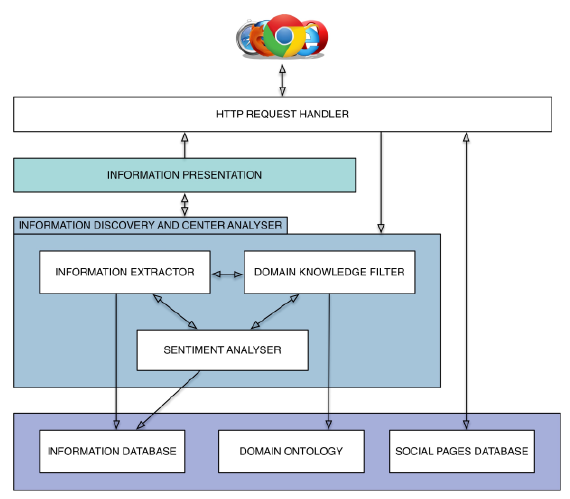
Figure 2 : Architecture of the platform used to measure the